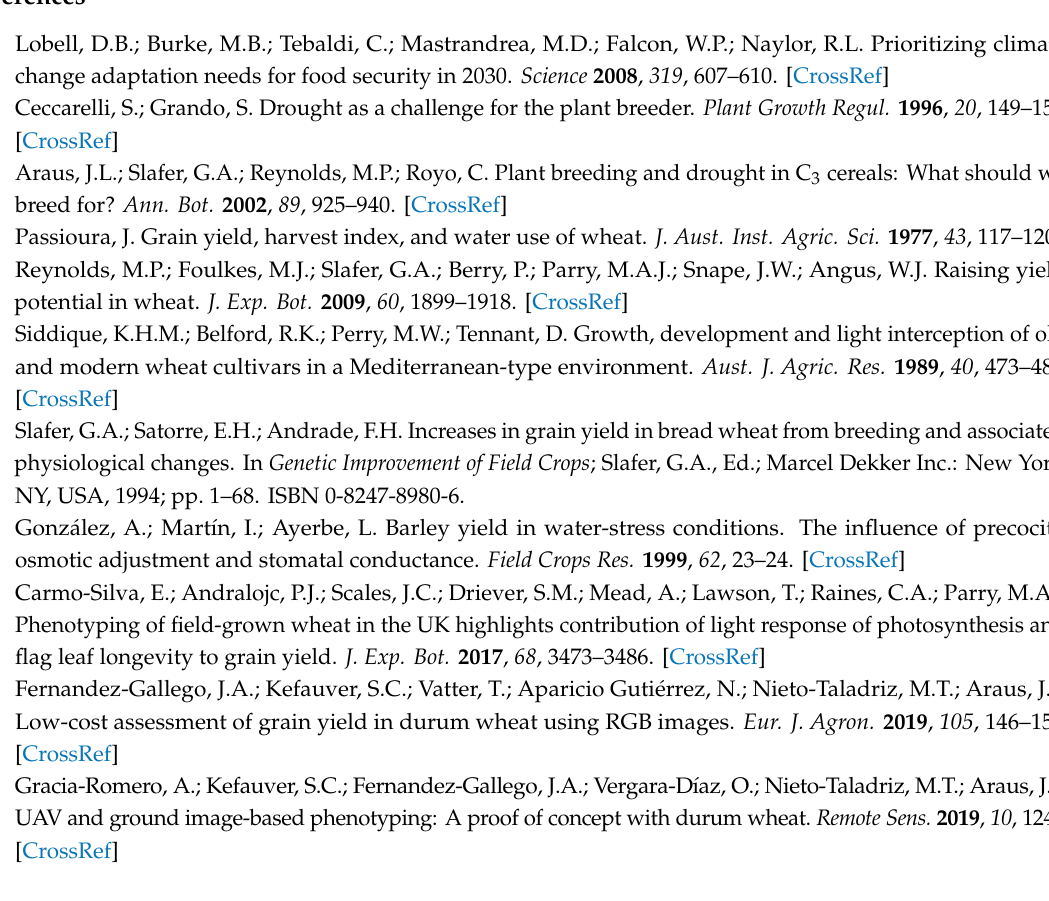
Table S1: Number of accessions at di ff erent flowering times and phenological stages, Table S2: Linear regression of the relationship between the biomass at mid grain filling and the NDVI, Table S3: Linear regression of the relationship between the biomass and δ 13C in the flag leaf dry matter sampled before imposition of stress and after two weeks of stress conditions, Figure S1: Image of the field trial at the Maricopa phenotyping